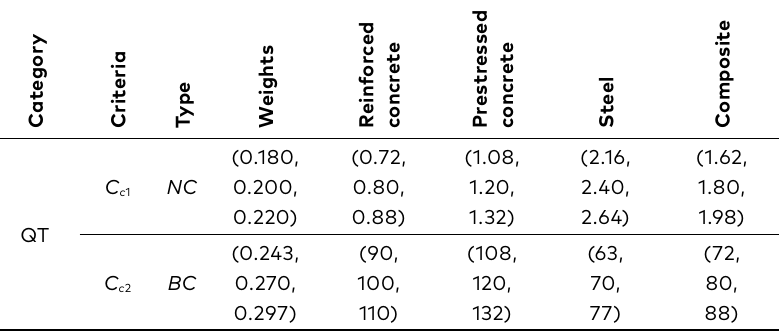
Table 5. The decision-matrix of the Materials